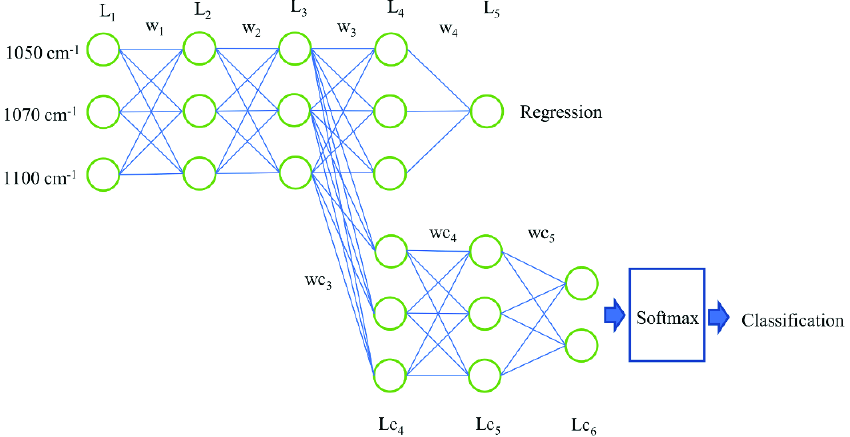
Fig. 4. Network diagram of